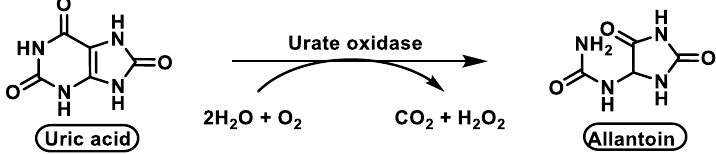
Figure 9. The enzyme urate oxidase converts uric acid into allantoin.